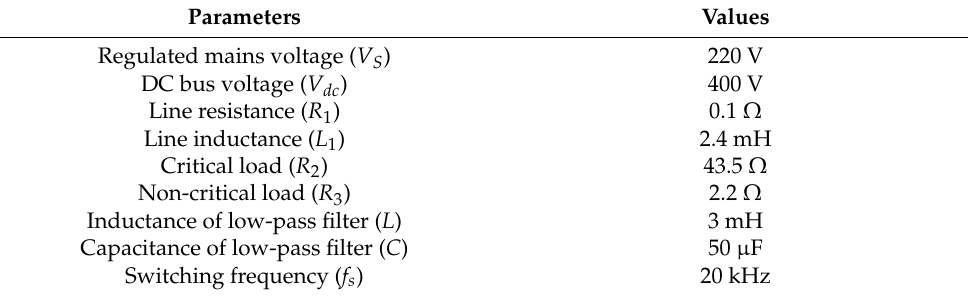
Table 1. Parameters for